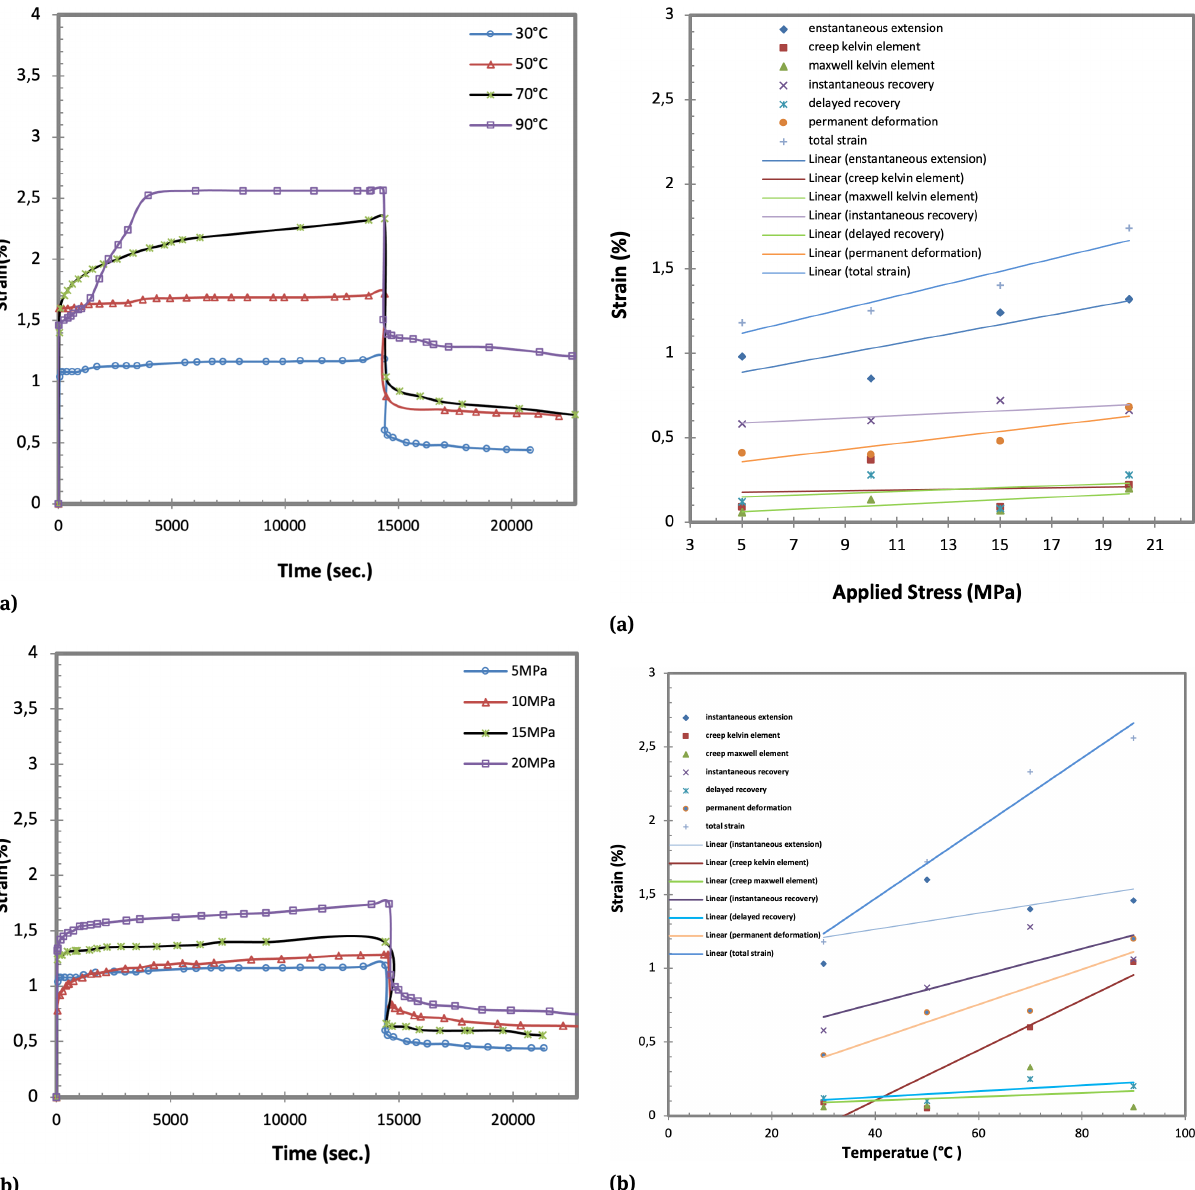
Figure 7: Variation of creep parameter of Epoxy/6% PSR blender reinforced with 30% E-glass fiber with (a) Applied stress, (b) Tem-